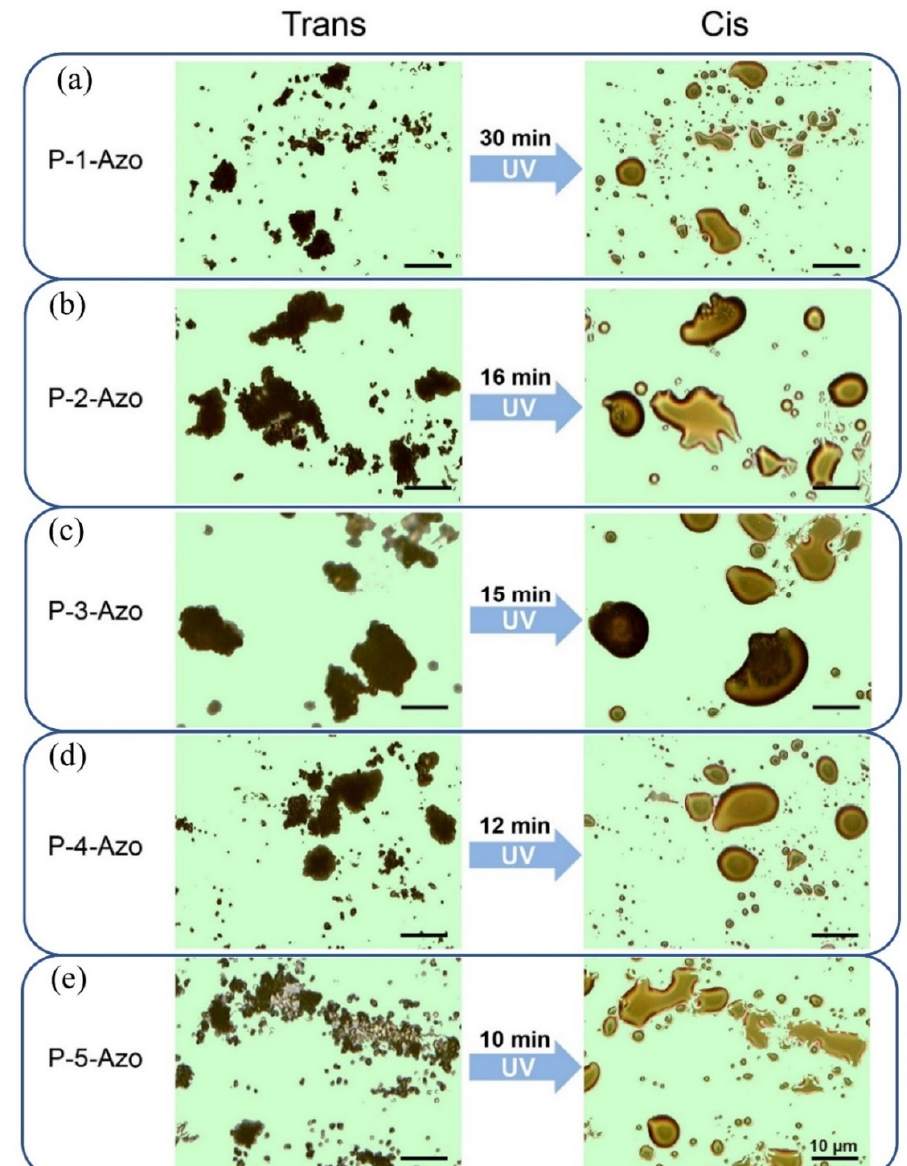
Figure 4. Photoinduced solid-to-liquid transition of azopolymers P-n-Azo ( n = 1–5, ( a – e )) upon UV (125 mW / cm 2 ) irradiation.